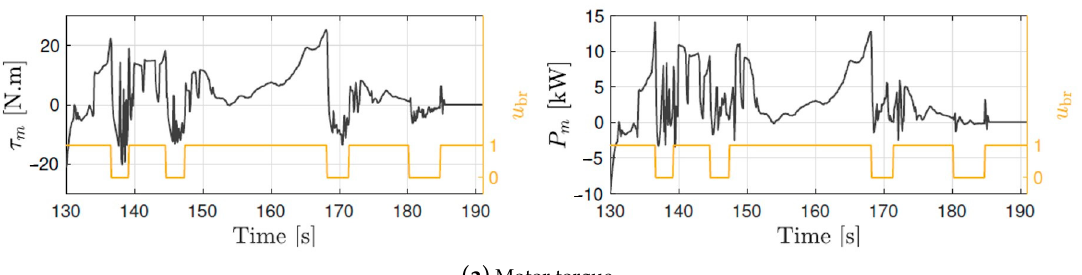
Figure 14. Engine and motor speed for the hardware-in-the-loop experiments during t = 130 s to t = 190 s.